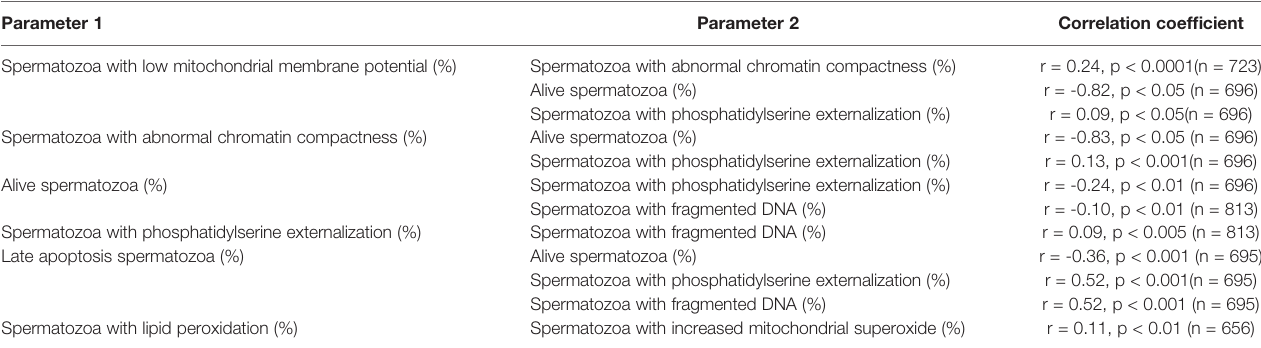
TABLE 2 | Spearman correlation analyses among bio-functional sperm